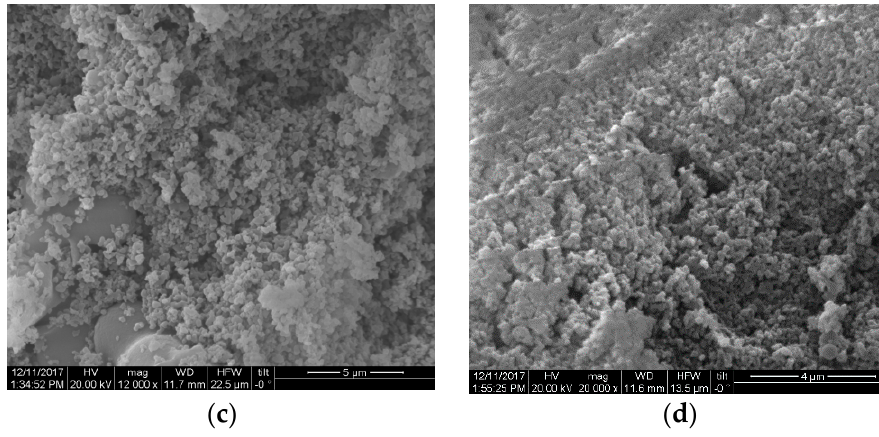
Figure 3. Morphology of lignin after HOS-SE pretreatment with ethanol content of ( a ) 50% v/v or